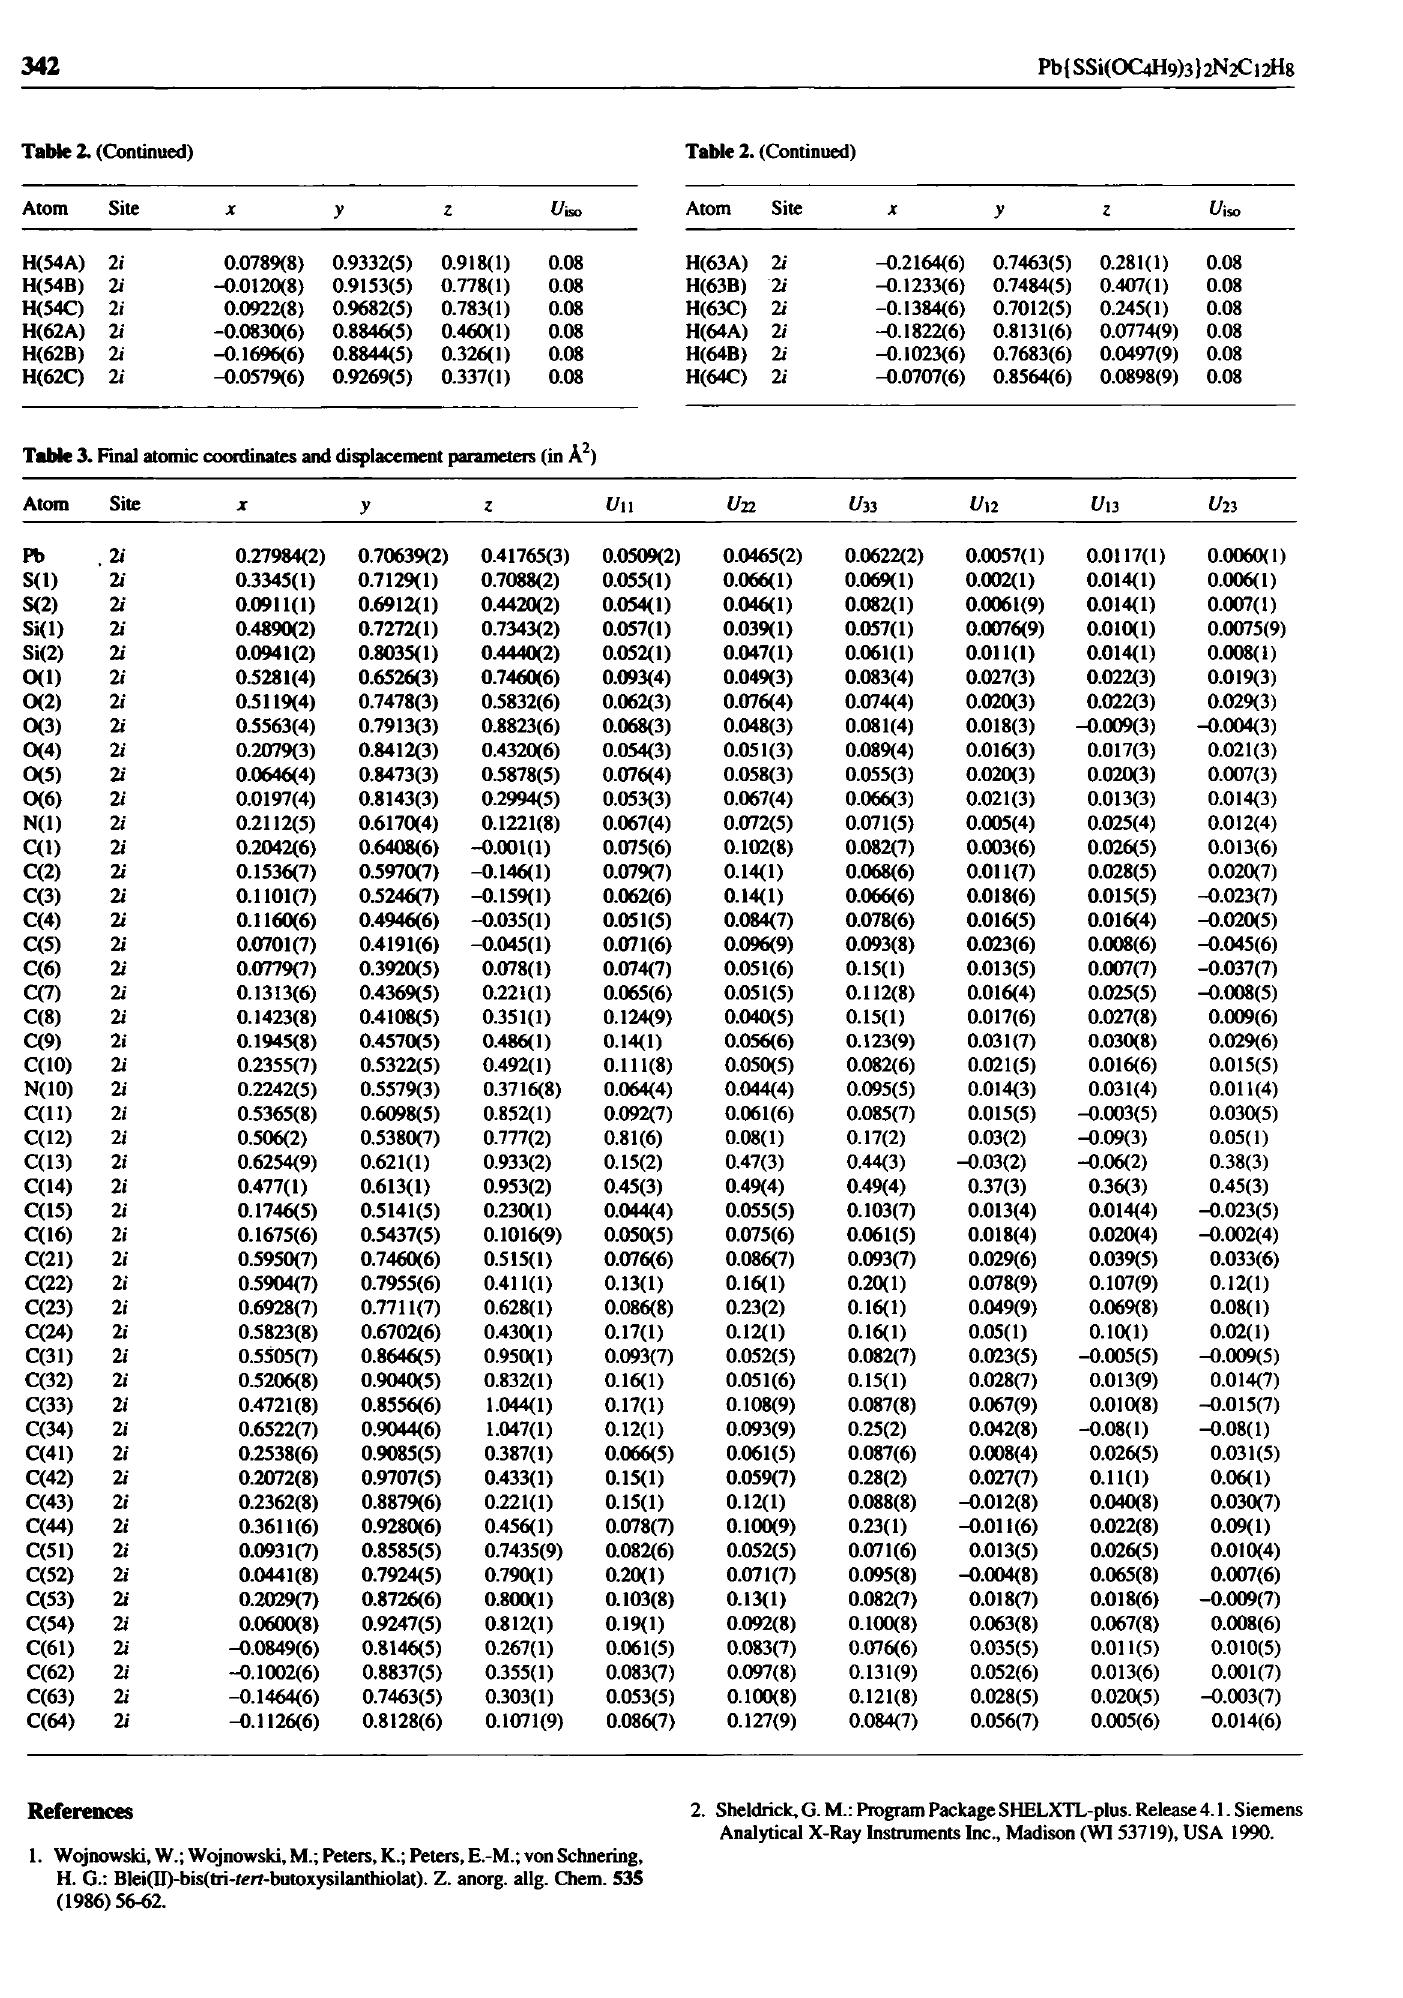
Table 3. Final atomic coordinates and displacement parameters (in À 2